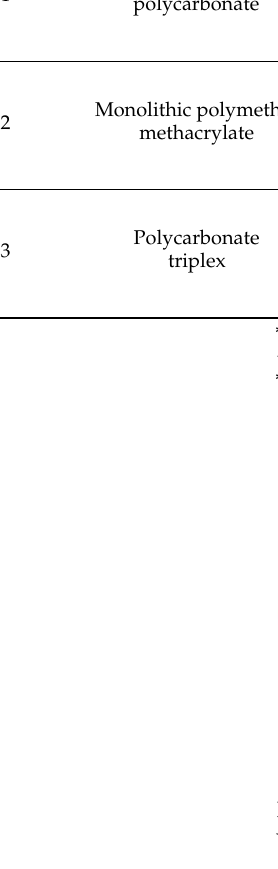
Figure 7. An example of slight deterioration in the adhesion strength of the coating for sample 1 treated according to option 2. 4. Discussion One of the important requirements for industrial and construction facilities operating in contact with an aggressive environment is their long-term resistance to bio-damage. For optically transparent organic materials, there is a constant search for new coatings that ensure the preservation of the optical – mechanical properties and, at the same time, are resistant to biofouling. The polysiloxane synthesized in this work is practically a cross- linked structure that covers organic glasses to enhance their resistance to biodeterioration.